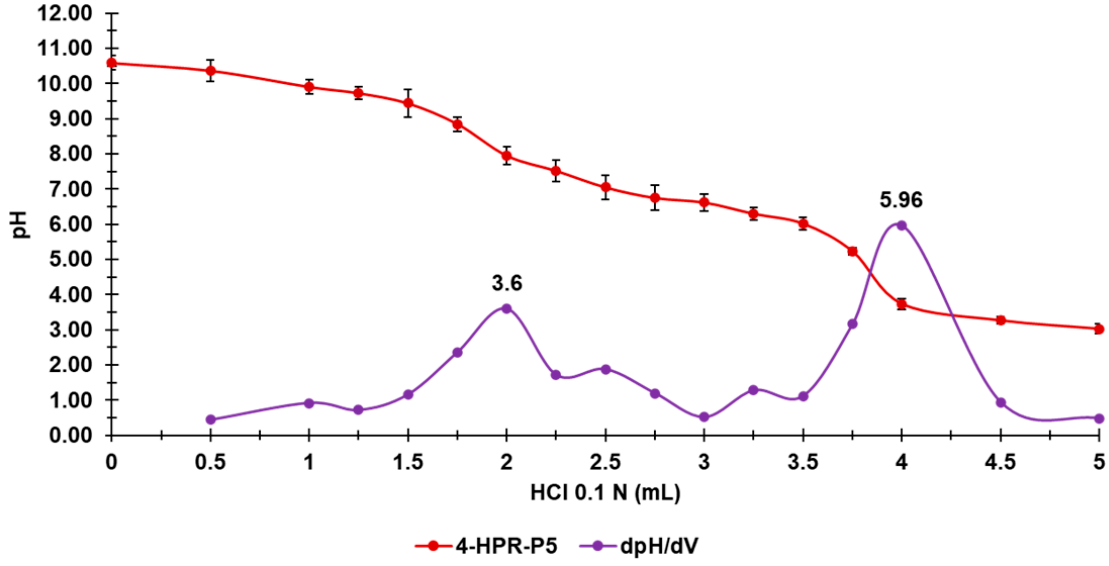
Figure 3. Potentiometric titration of 4-HPR-P5 (red line); first derivative (dpH/dV) of the titration curve (purple line).